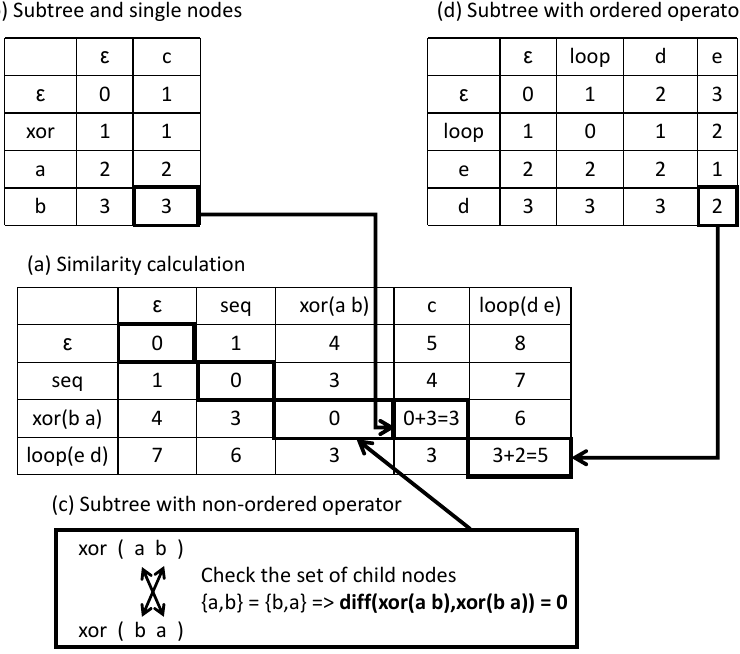
Figure 10. An illustration of the similarity calculation of two process tree formulas. ( a ) Distance calculation at main formula; ( b ) when comparing subtree and single nodes, we check if the single node is a child of the subtree’s operator; ( c ) for a subtree with a non-ordered operator, we check the set of child nodes. For the same subset, the distance is 0; ( d ) for a subtree with an ordered operator, we check the sequence by recursively calling the modified Levenshtein function lev X , Y